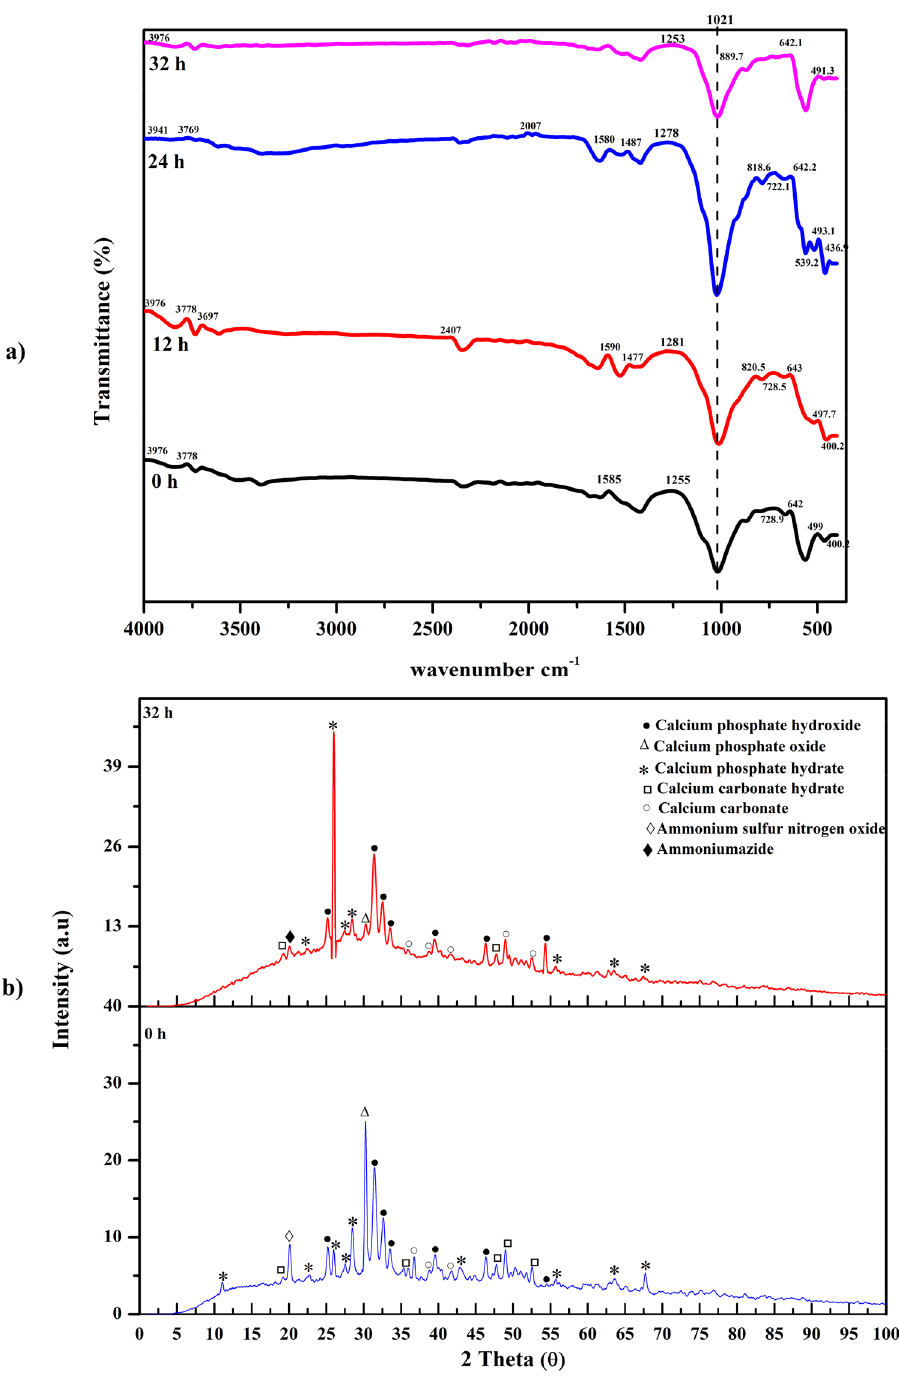
Figure 12. (a) FTIR pattern rock phosphate residual samples at zero, 12, 24, and 32 h incubation time and ( b) XRD analysis chart of rock phosphate leftover samples at zero and 32 h of incubation